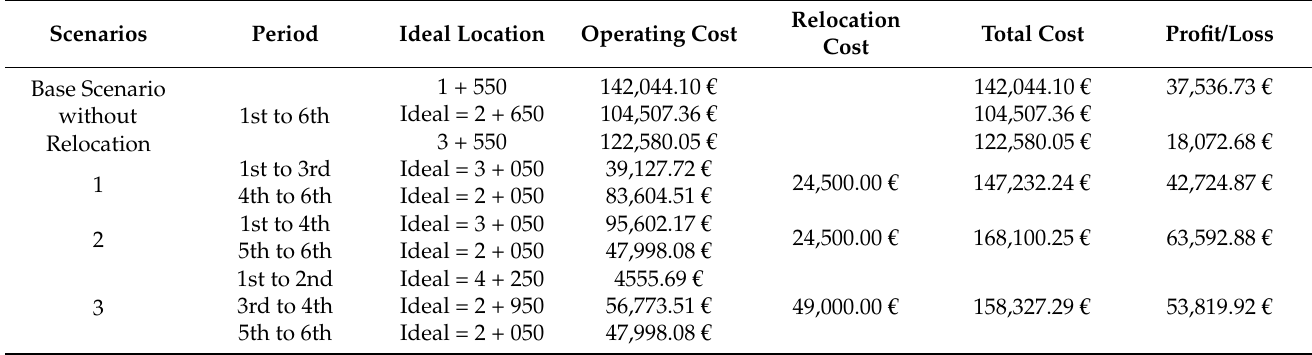
Table 5. Operating costs results of the first